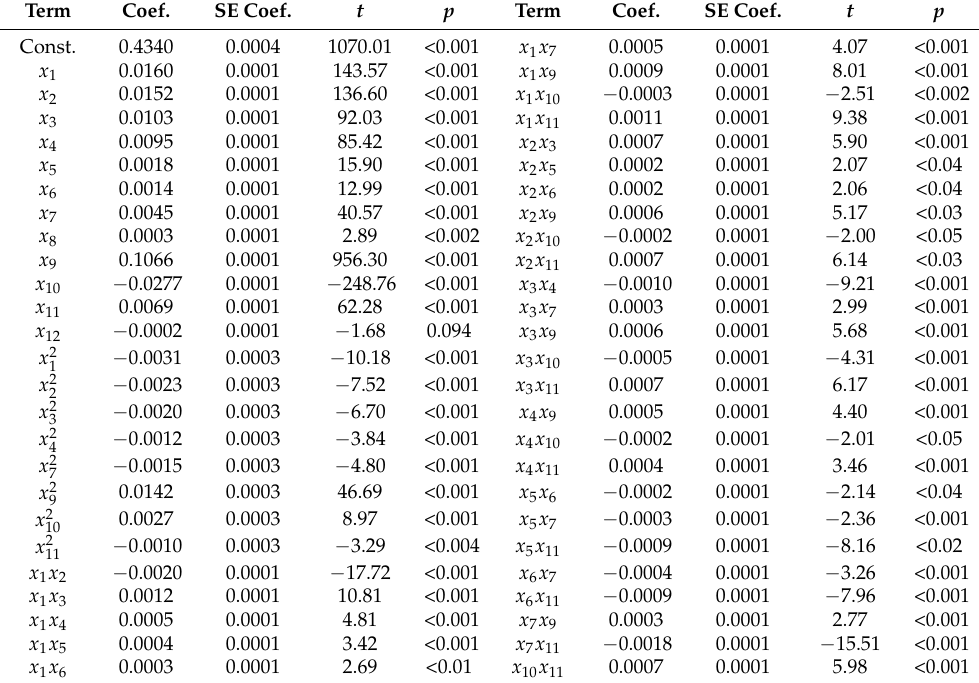
Table 6. Result of regression analysis and selected terms (strategy